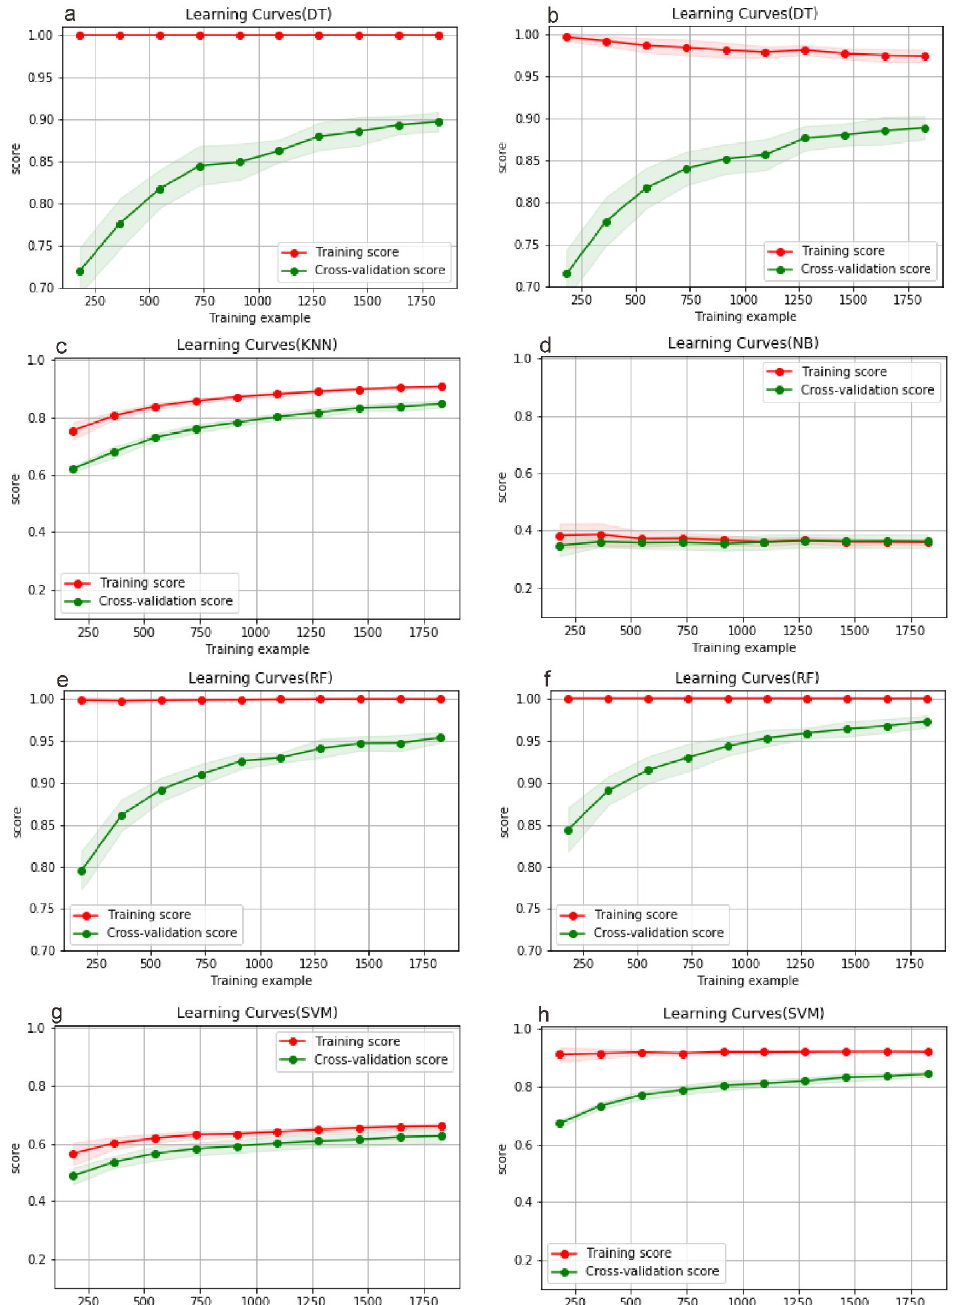
Figure 2. The learning curves of ML-classifiers. ( a ) decision tree classifier, ( b ) decision tree classifier after tuning hyperparameters, ( c ) K-nearest neighbors classifier, ( d ) naive Bayes classifier, ( e ) random forest classifiers, ( f ) random forest classifier after tuning hyperparameters, ( g ) support vector machine classifier, ( h ) support vector machine classifier after tuning hyperparameters.